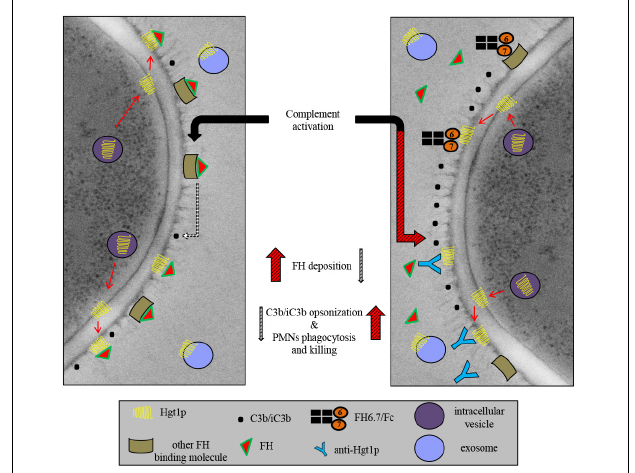
FIGURE 7 | Schematic representation of Hgt1p complement inhibition model. Hgt1p is carried to the cell wall by exosomes. The protein crosses the cell wall and acts as a FH binding molecule. Blockage of FH binding and the resulting up-regulation of C3b/iC3b conversion and deposition on fungal surface increases phagocytosis by